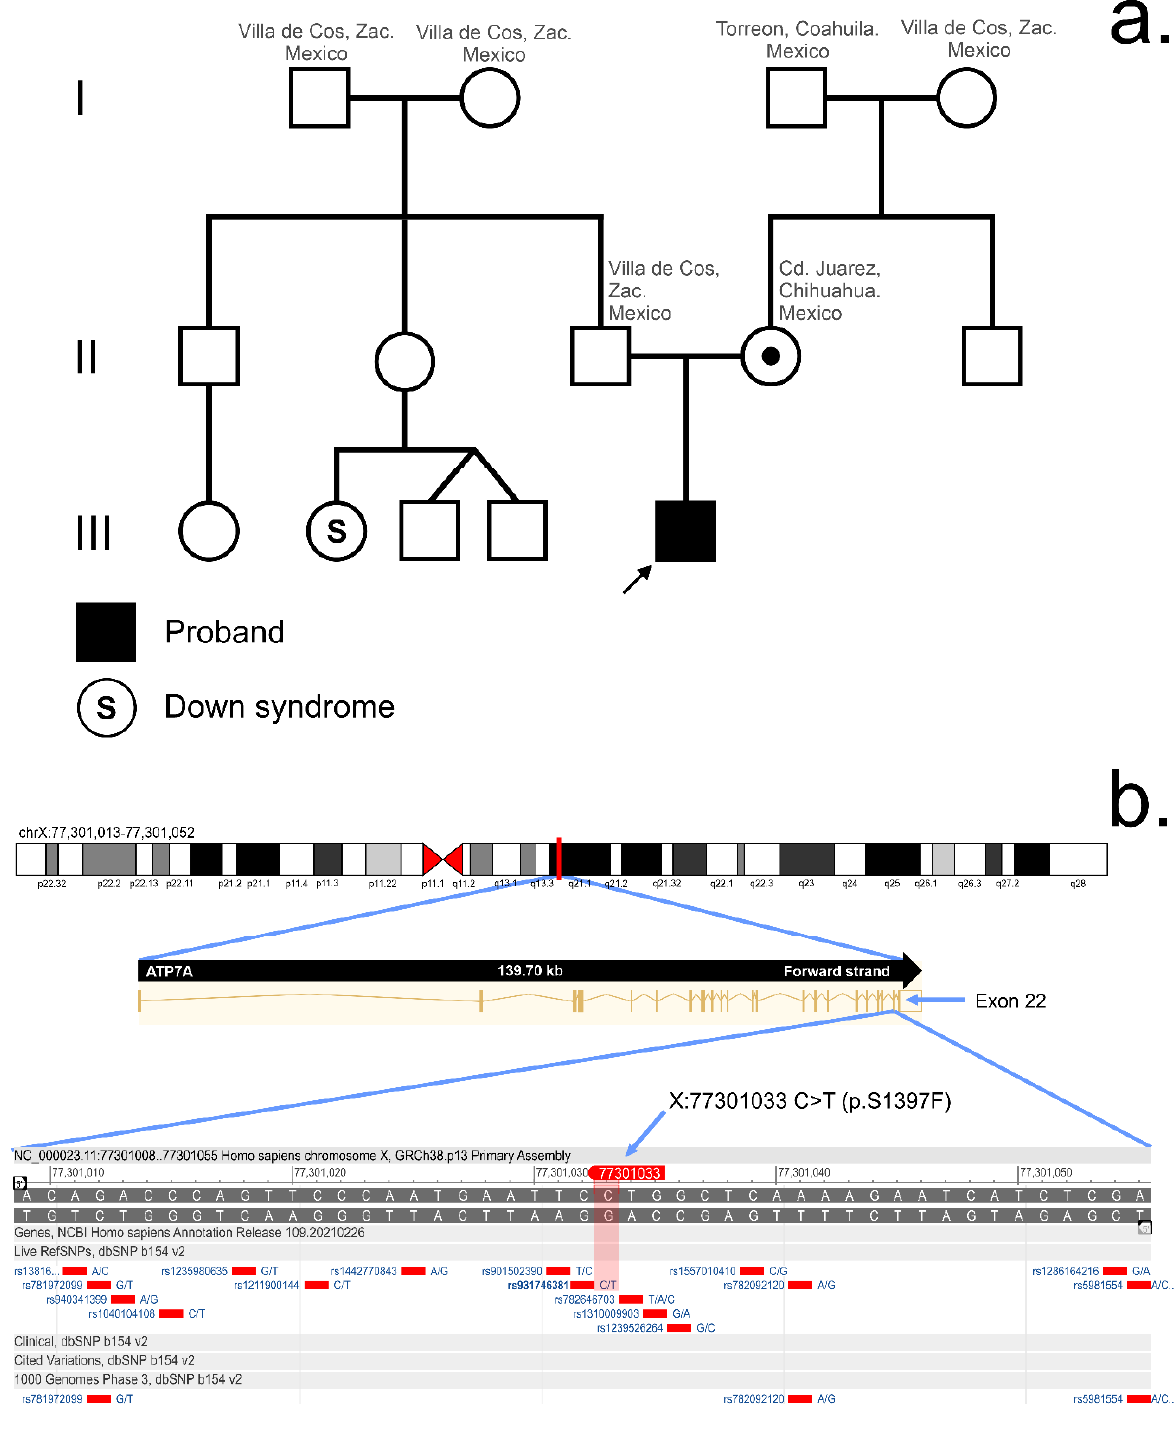
Figure 1. Pedigree chart and representation of the c.4190C > T variant. ( a ) The proband was born of non-consanguineous parents and he had no family history of hereditary diseases. ( b ) Representation of the location of the hemizygous c.4190C > T ( p S1397F) variant: X: 77301033 C > T exon 22 of the ATP7A